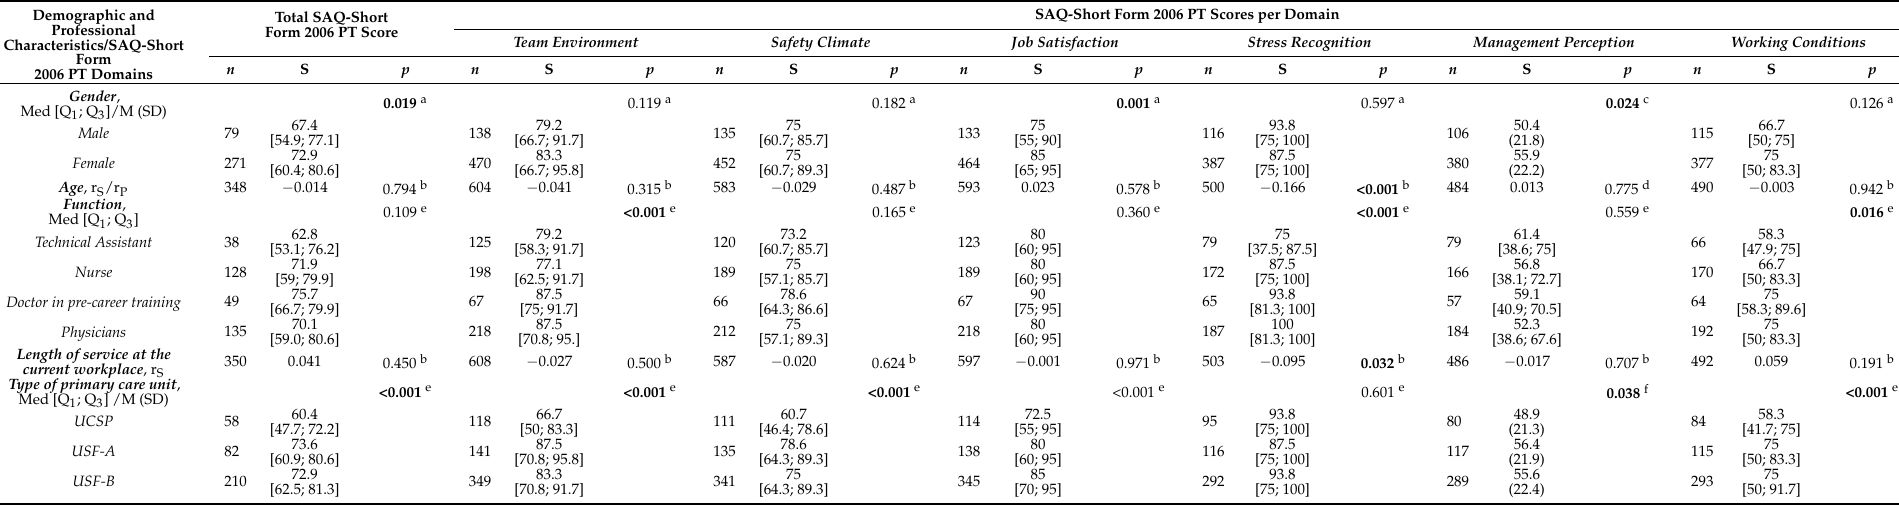
Table 4. Descriptive analysis of the SAQ—Short Form 2006 PT and comparison with demographic and professional